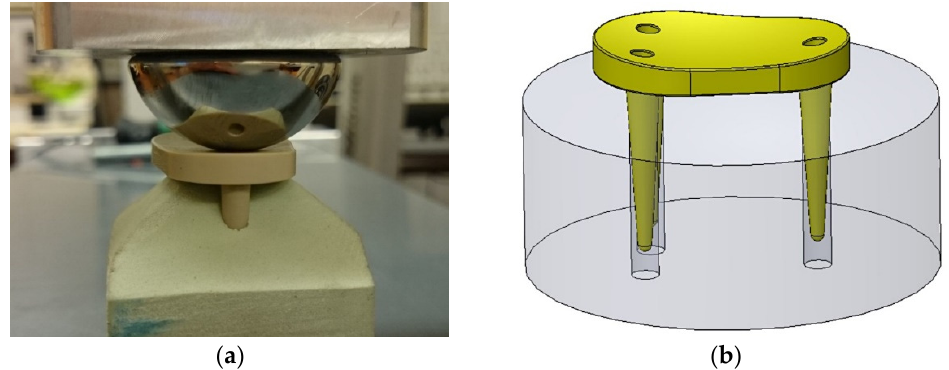
Figure 11. Test abutment for the dynamic implant variant: ( a ) view of the actual test setup; ( b ) schematic view of the test block.